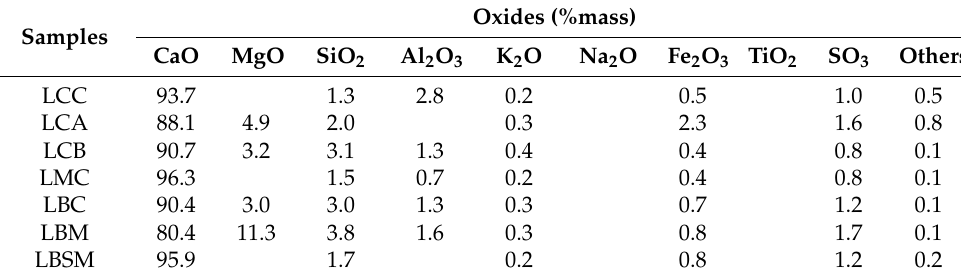
Table 3. Chemical composition of the limestones investigated in this